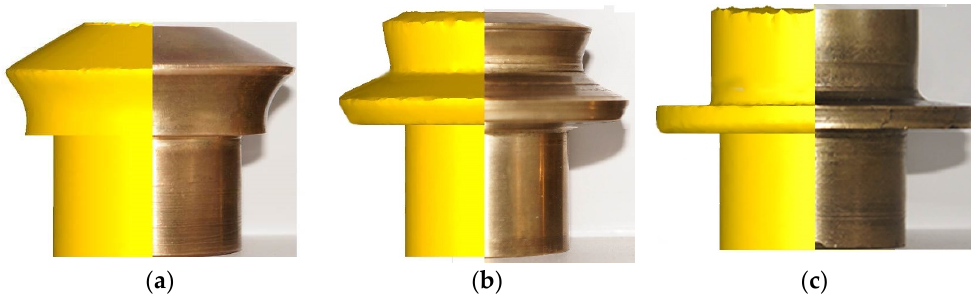
Figure 6. Comparison of computer and physical simulation forms for the angular rolling of a flange part at the rational angles of dip of rolling rolls: ( a )—the first stage of rolling; ( b )—the second stage of rolling; ( c )—the third stage of rolling.